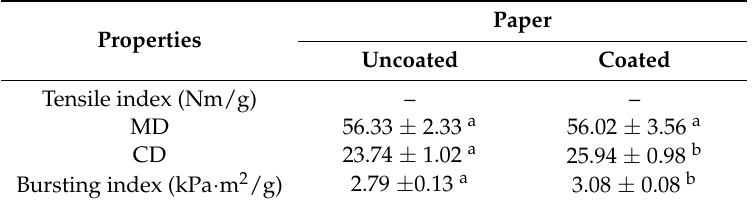
Table 4. The bursting and tensile index of the uncoated and coated paper.